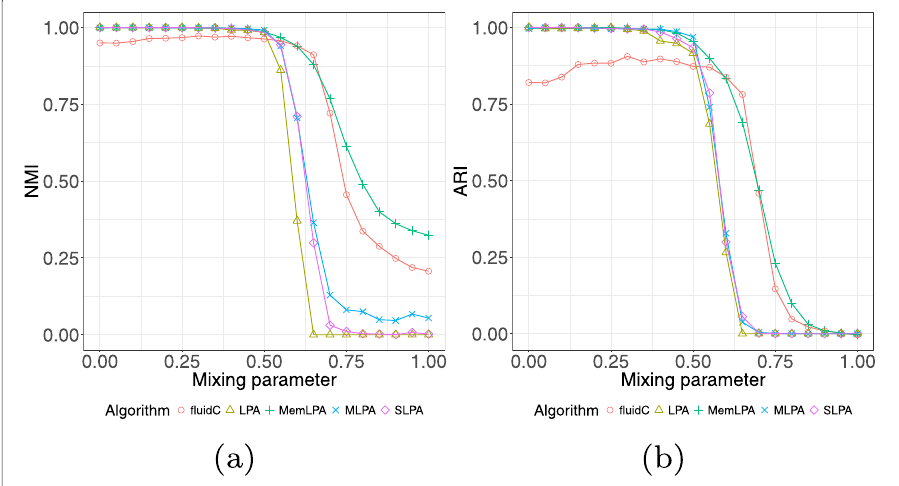
Fig. 3 Experiments on the LFR benchmark. Experiments are run 20 times and results